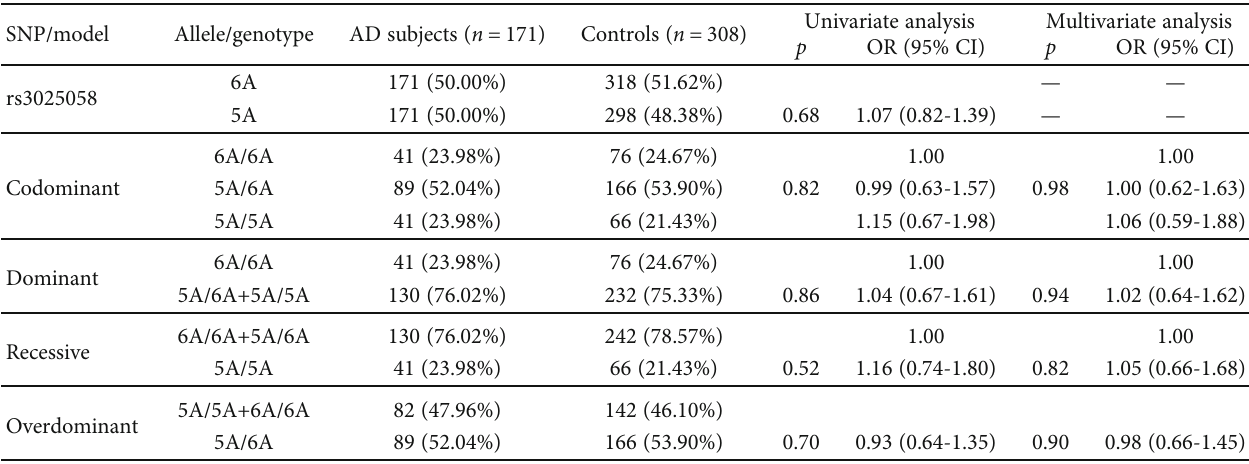
Table 3: Allele and genotype frequencies of MMP3 polymorphism rs3025058 (-1171 5A/6A) in AD patients and controls.